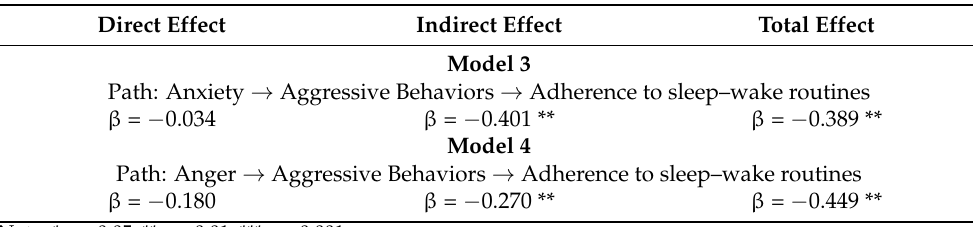
Table 6. Results of mediation Models 3 and Model 4.